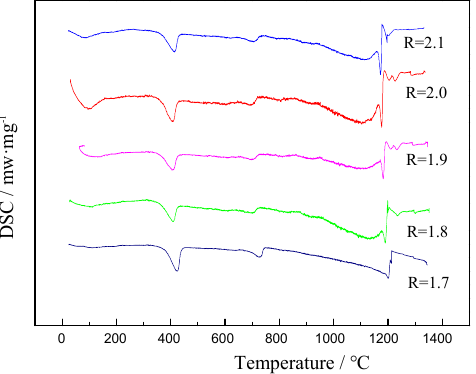
Figure 3. DSC curves of raw materials with different basicity values.